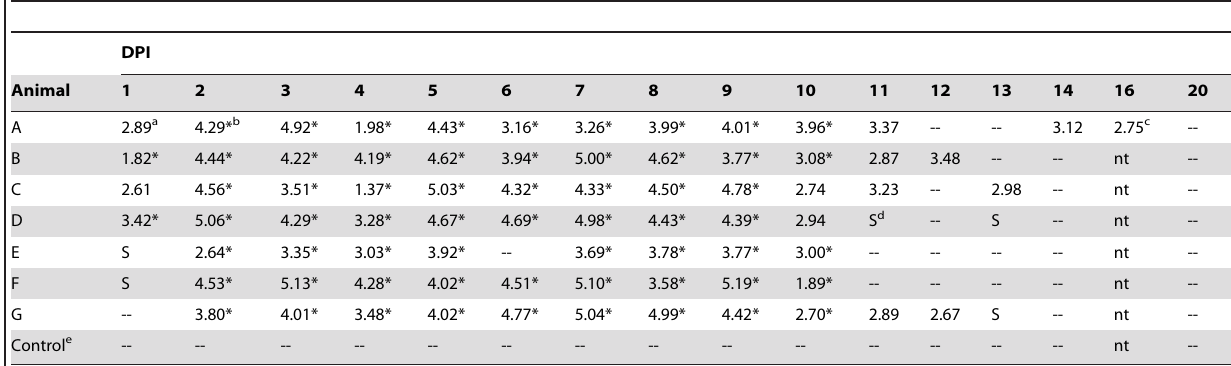
Table 3. Oral shedding of striped skunks ( Mephitis mephitis ) experimentally infected with an avian influenza virus (H4N6).